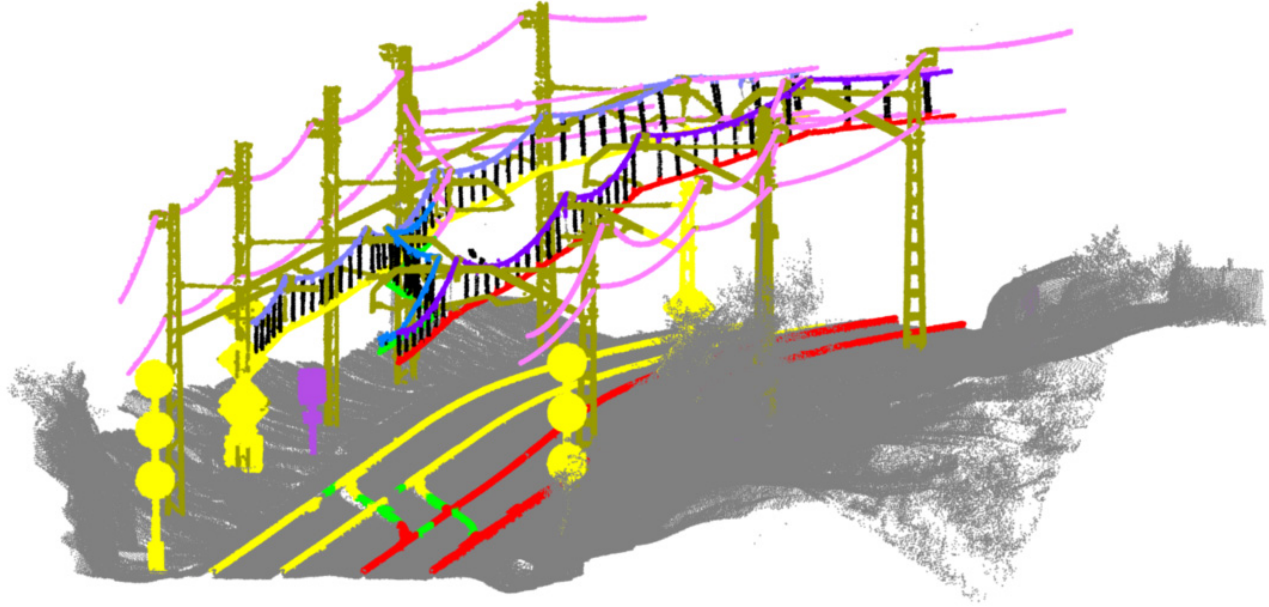
Figure A1. Railway switch: masts are represented in gold colour. Each contact wire has a different colour (yellow, green, and red), matched by its correspondent rail. Each catenary has also a random colour. Other wires are coloured in pink, droppers in black, signs in yellow, and marks in magenta.